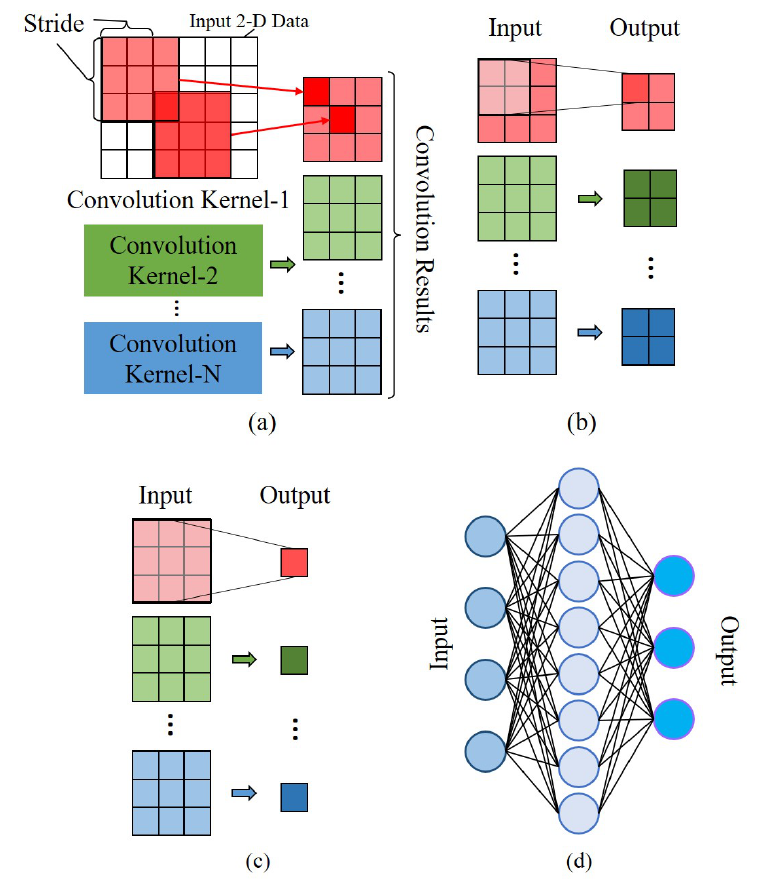
Figure 2. Schematic diagram of the operation process of CNN. ( a ) Convolution layer, ( b ) General pooling layer, ( c ) Global averaging pooling layer, ( d ) Fully connected